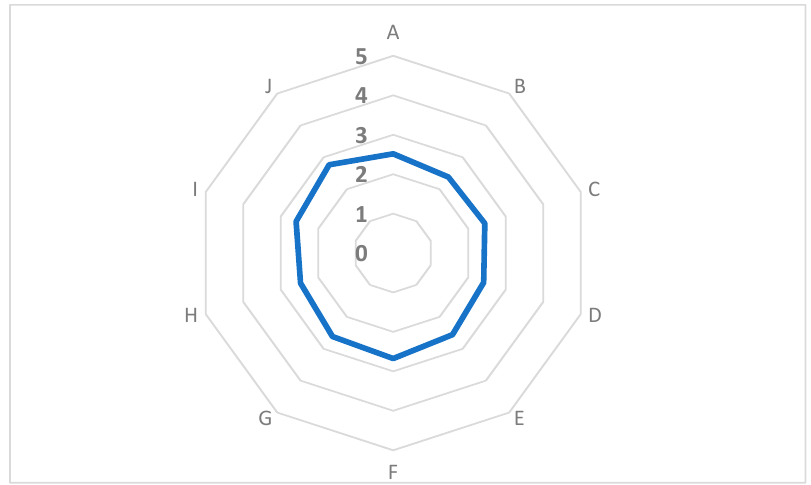
Figure 7. Average assessment of the scope of support by the indicated activities of the sustainable